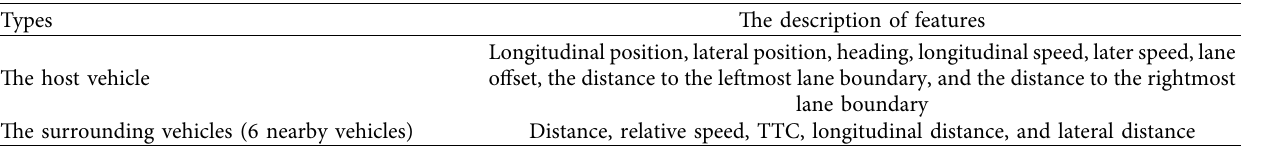
Table 1: State representation.